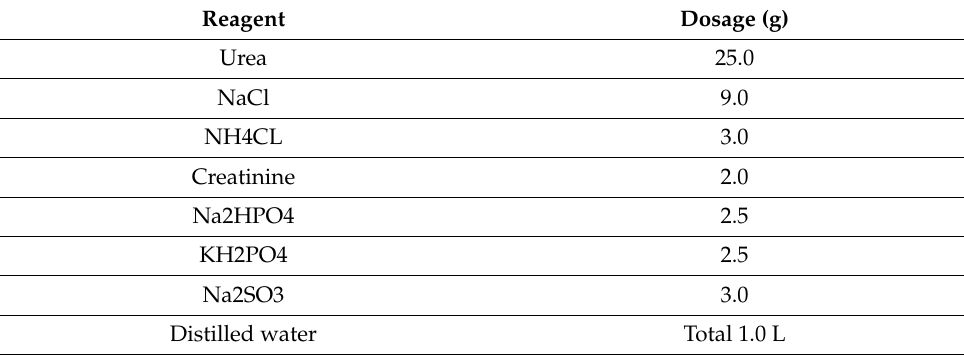
Table 2. Artificial body urine (pH 6.6): chemical